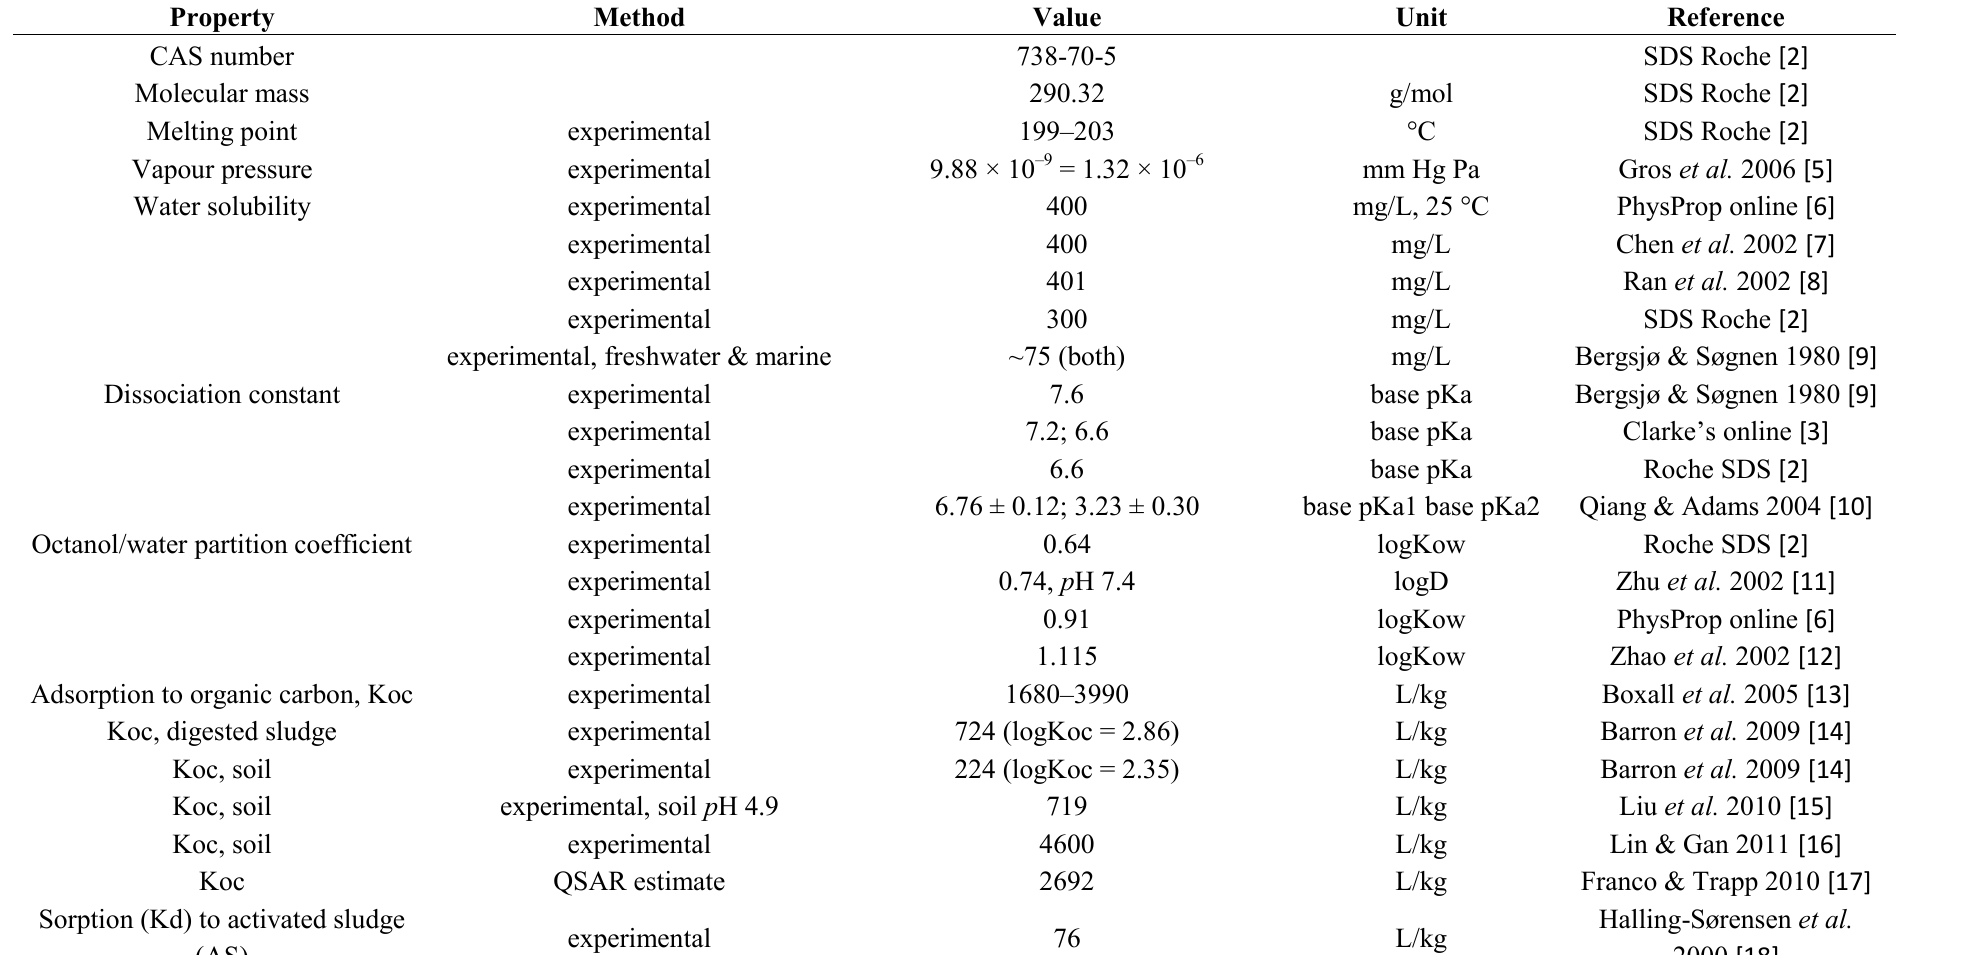
Table A1. Physico-Chemical Data for